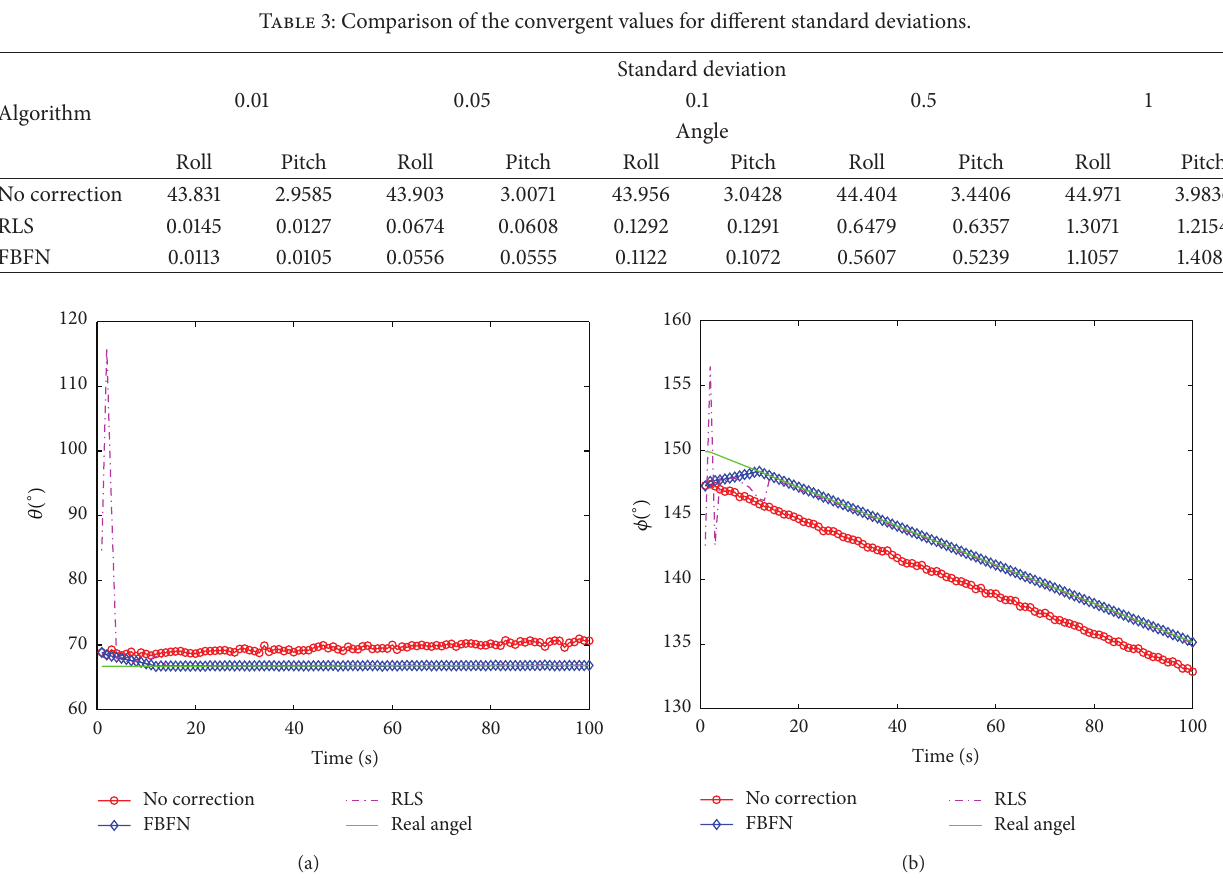
Figure 12: (a) Elevation and (b) horizontal beam pointing error compensation for circular maneuvering target.